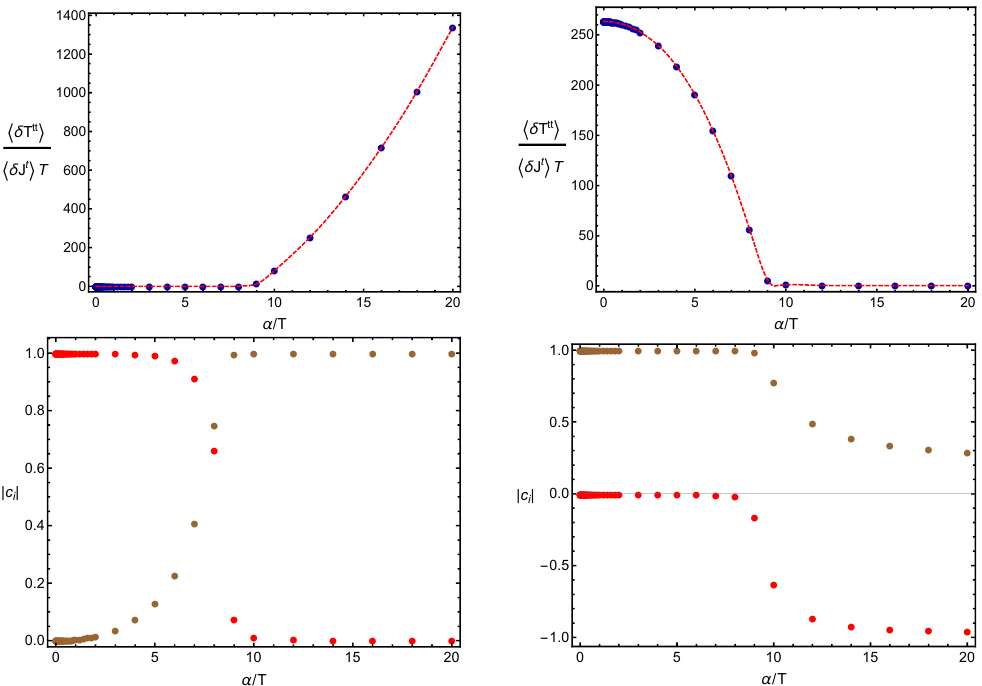
Figure 14 . Top : the relative amplitudes of h δT tt i and h δJ t i for the two thermoelectric diffusion modes at T/µ = 5 (in blue, corresponding to the data in figure 7) and the hydrodynamic prediction for the ratio (dashed red line). Bottom : the normalized, dimensionless coefficients c c T 3 in the basis of the eigenvectors from eq. (C.5). In the incoherent limit α (cid:29) µ , δJ + → δJ t δT tt and δJ tt + γ t . This implies that δJ − is purely δJ t and the other mode is still a mixture − ∼ δT − αδJ of δT tt and δJ t . The relative coefficient of the bottom right plot is presented in figure